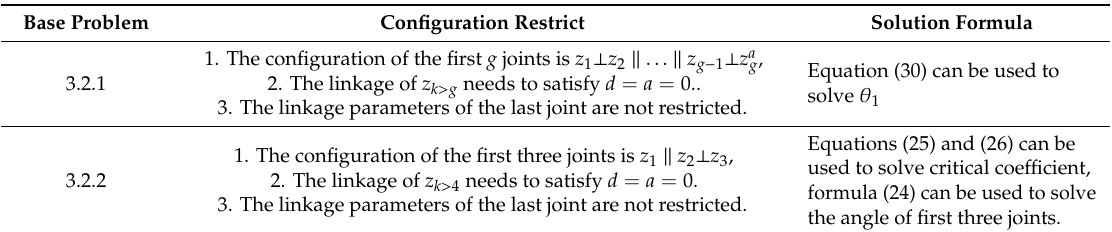
Table 5. The restrictions and solution formula of the two basic problems.